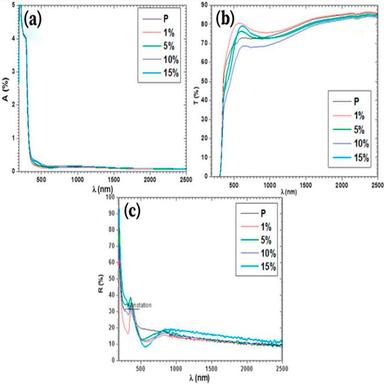
(a)–(c) Absorption, transmission and reflectance graphs of films.